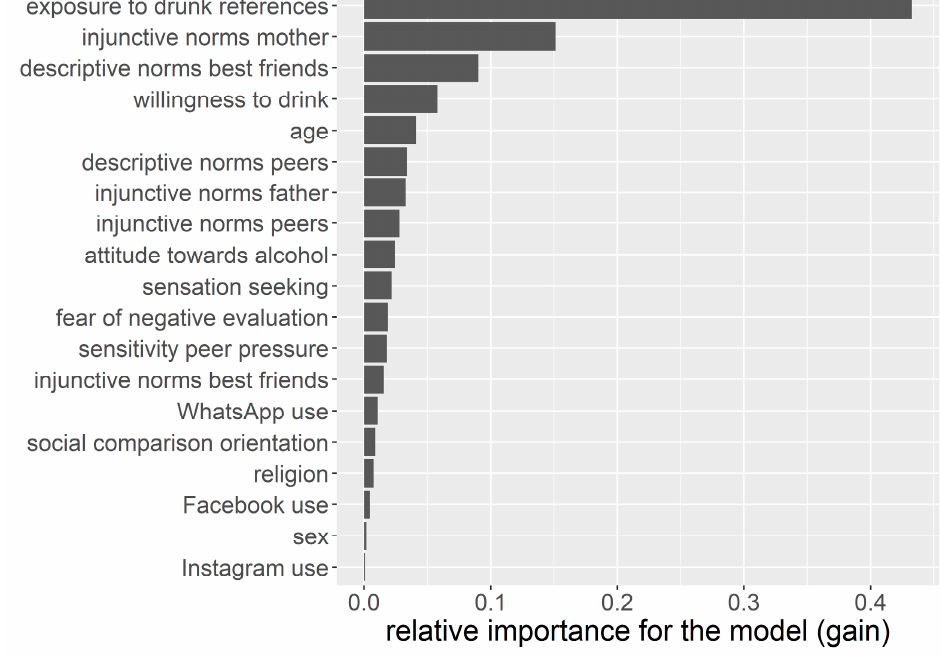
Figure 3. Relative Feature Importance.